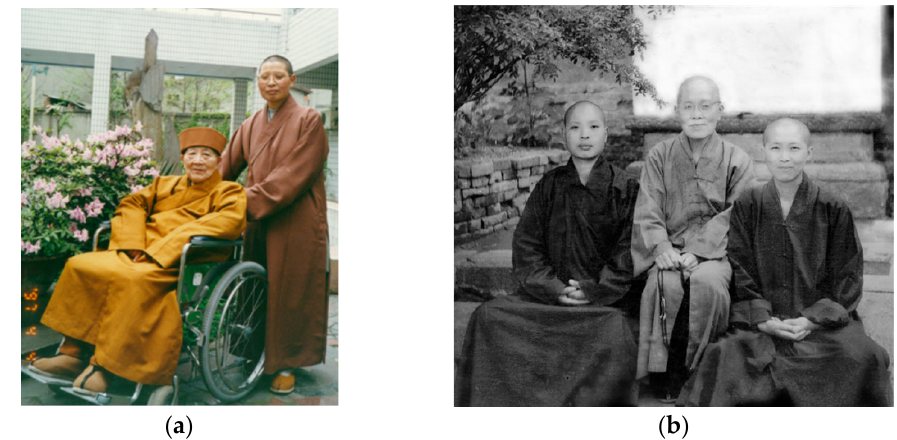
Figure 3. Rurui and her teachers (source: Pushou temple). ( a ) Longlian & Rurui, 1997; ( b ) Rurui, Tongyuan, Miaoyin ( 妙音 , 1957–), 1983, Nanshan temple ( 五台山南山寺 ).